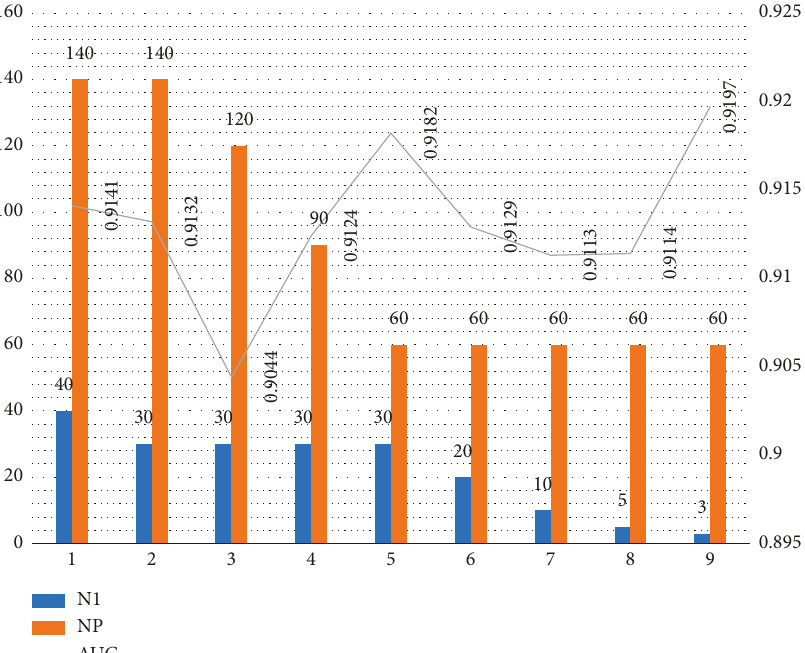
Figure 4: Influence of the number of neurons in the first pyramidal layer (N1) and in the point cloud (NP) of the SPNN.